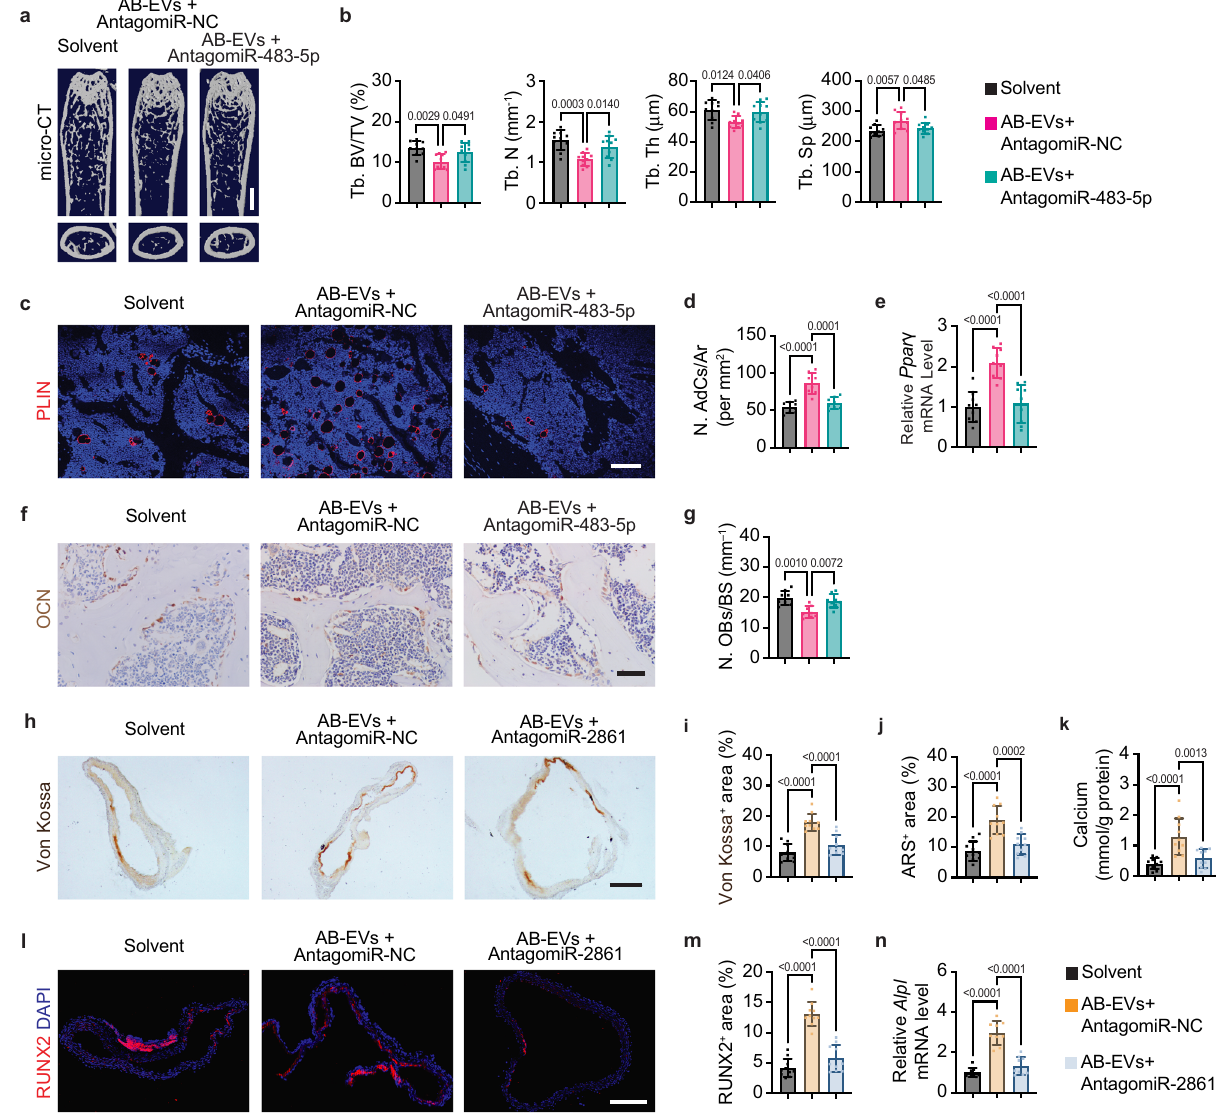
Fig. 7 miR-483-5p and miR-2861 contribute to AB-EVs-induced marrow adiposity and calci fi cation paradox. a μ CT-reconstructed images of femurs from 3-month-old young mice treated with solvent or AB-EVs pre-treated with antagomiR-NC or antagomiR-483-5p. Scale bars: 1 mm. b Quanti fi cation of Tb. BV/TV, Tb. N, Tb. Th, and Tb. Sp. n = 10 biologically independent animals per group. c – d PLIN immuno fl uorescence staining images ( c ) and quanti fi cation of the number of PLIN + (red) adipocytes in bone marrow ( d ). Scale bar: 100 μ m. n = 8 biologically independent animals per group. e qRT- PCR analysis of Ppar γ expression. n = 9 biologically independent animals per group. f – g , OCN immunostaining images ( f ) and quanti fi cation of the number of OCN + (brown) osteoblasts on BS ( g ). Scale bar: 50 μ m. n = 8 biologically independent animals per group. h – j Von Kossa staining images ( h ), quanti fi cation of the percentage of Von Kossa + (brownish black; i ) and ARS + (red; j ) areas in abdominal aortas from the VD3-induced acute vascular calci fi cation mouse models receiving solvent or AB-EVs pretreated with antagomiR-NC or antagomiR-2861. Scale bar: 200 μ m. n = 10 biologically independent animals per group. k Vascular calcium content analysis. n = 10 biologically independent animals per group. l – m , RUNX2 immunostaining images ( l ) and quanti fi cation of the percentage of RUNX2 + areas (red; m ). Scale bar: 200 μ m. n = 10 biologically independent animals per group. n , qRT- PCR for Alpl expression. n = 9 biologically independent animals per group. All experiments were performed with at least eight biological replicates per group without independent repetition. Data were presented as mean ± SD. Statistical signi fi cance was determined by one-way ANOVA with Bonferroni post hoc test. Source data are provided as a Source Data fi le. with the antagomiR-NC-pre-treated AB-EVs, but the antagomiR- miR-483-5p in AB-EVs-induced bone-fat imbalance. The role of 483-5p-pre-treated AB-EVs failed to stimulate the accumulation miR-2861 in the AB-EVs-induced promotion of vascular calci fi - of marrow adipocytes and Ppar γ expression (Fig. 7c, d). Immu- cation was assessed in 3-month-old mice subjected to VD3 nohistochemical staining for OCN indicated that the mice treated treatment. Von Kossa and ARS staining indicated that the inhi- with the antagomiR-NC-pre-treated AB-EVs exhibited a sig- bition of miR-2861 in AB-EVs by antagomiR-2861 prominently ni fi cant reduction in osteoblast number, but the alteration did not reduced, but did not entirely block, the AB-EVs-induced occur in the mice treated with the antagomiR-483-5p-pretreated increases of calcium deposition areas in the mouse abdominal AB-EVs (Fig. 7f, g). These fi ndings determine the essential role of aortas (Fig. 7h, j). Vascular calcium content analysis further NATURE COMMUNICATIONS| (2022) 13:1453